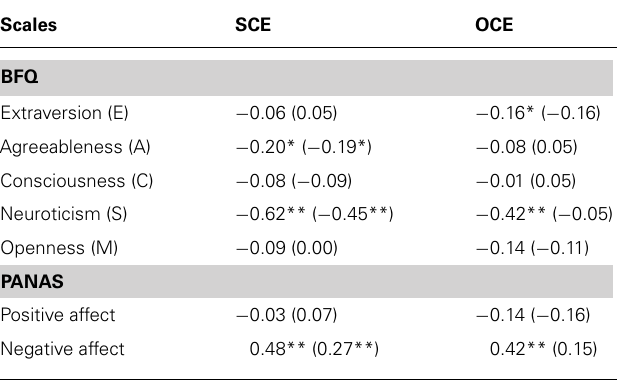
Table 5 | Bivariate correlations and semipartial correlations of SCE, OCE with BFQ and PANAS scales. Scales